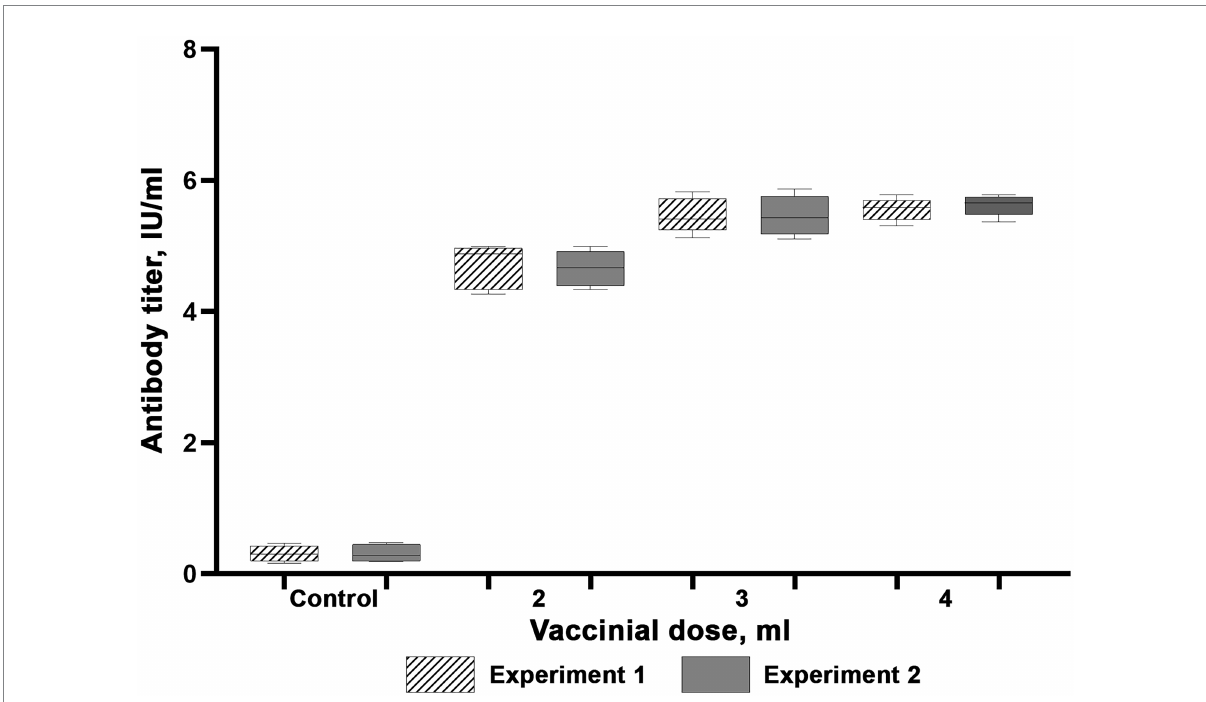
FIGURE 4 Virus-neutralizing activity of blood serum of reindeer once immunized with the Liquid vaccine. Two independent experiments (Experiment 1 and Experiment 2). In each experiment, 15 animals were vaccinated (five animals per each dose). Four unvaccinated animals were used as a control group. Reindeer blood serum were collected 21 days after administration. Maximum and minimum titres are illustrated with whisker caps, interquartile range with a box with the median denoted by a horizontal